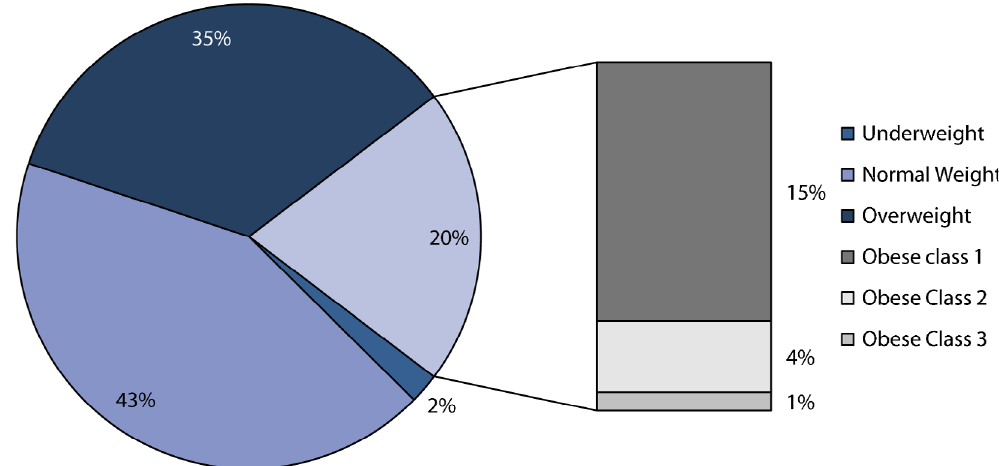
Figure 1: Distribution of BMI.